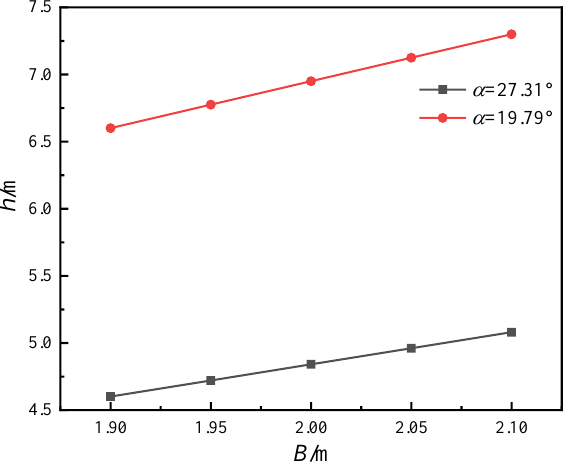
Figure 8. Relationship between mining height h and width B .